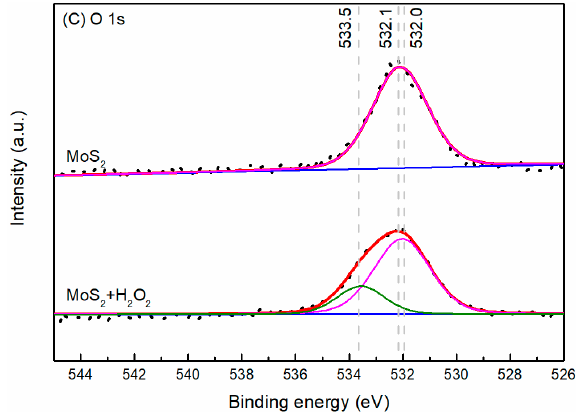
Figure 13. XPS spectra of molybdenite: ( A ) Mo 3 d , ( B ) S 2 p , ( C ) O 1 s . Dots represent the experimental spectrum, heavy red solid lines indicate the best fit curve, and the individual XPS peaks are shown as thin solid lines in different colors.